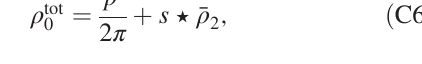
FIG. 7. TBA incidence diagrams depicting the complete thermodynamic quasiparticle spectra for a number of paradig- matic examples of massive and massless IQFTs with isometry groups of rank one: SU(2) chiral Gross-Neveu model, O(3) nonlinear sigma model, with and without the topological Θ term and SU(2) principal chiral field, appearing from top to bottom in the respective order. Massive physical excitations, with bare dispersion [Eq. (C3)], are designated by gray nodes. Massless physical excitations, with bare dispersion [Eq. (C9)], are marked in blue. The structure of TBA equations is a direct product of two types of Dynkin diagrams: a finite one associated with the isometry group of the elementary physical excitations (marked with color nodes), and an infinite one of type A associated with a tower of auxiliary magnons (white nodes), whose bijectives cor- respond to finite-dimensional irreducible su ð 2 Þ